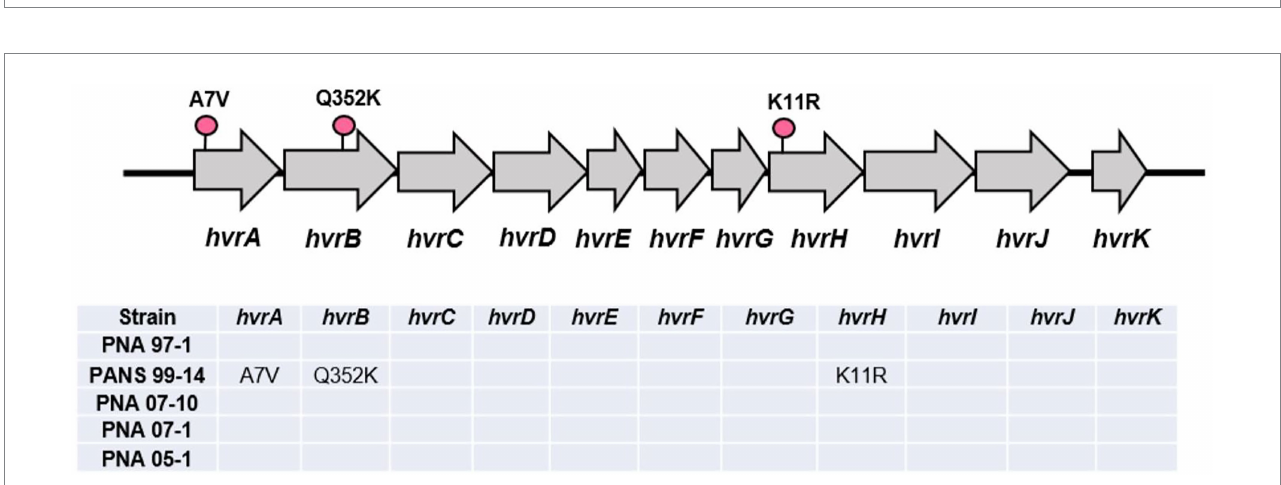
FIGURE 7 Graphical representation of the HiVir cluster with single nucleotide polymorphisms (SNPs) determined via direct comparison with the PNA 97-1 “wildtype.” Unique missense SNPs are coded with a pink pin. A short table below shows SNP comparisons between the A. fistulosum × A. cepa pathogenic strains (PNA 07-10, PNA 07-1, and PNA 05-1) against the A. porrum pathogenic strains (PNA 15-3 and PANS